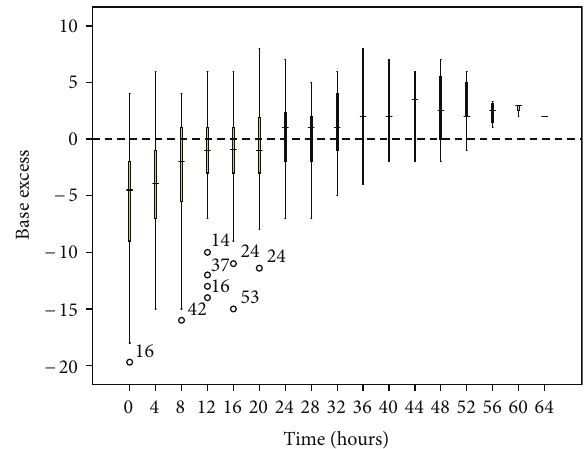
Figure 5: Base excess changes over time during citrate CRRT. Standard box plot in which the horizontal line represents the median,thethicklinerepresentstheinterquartilerange,andthethin line represents the maximum and minimum values. The circular dots represent the